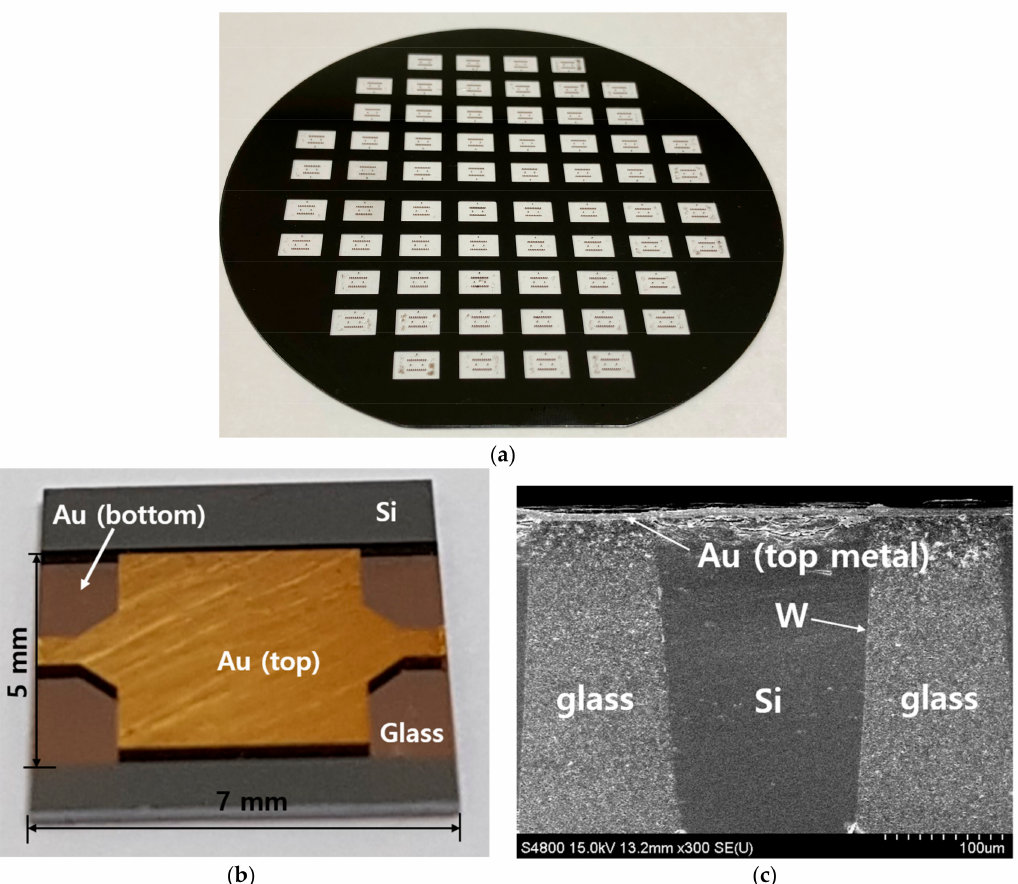
Figure 4. ( a ) Photograph of the wafer after glass reflow and chemical mechanical polishing (CMP) processes; ( b ) Photograph of the fabricated SIW; ( c ) Magnified scanning electron microscope (SEM) image of the silicon via embedded in the glass